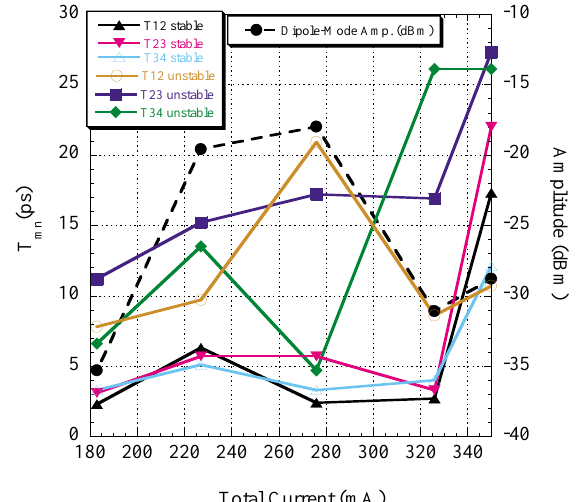
FIG. 16. (Color) The time deviation between adjacent bunches in a train as a function of current, with and without the instability present.